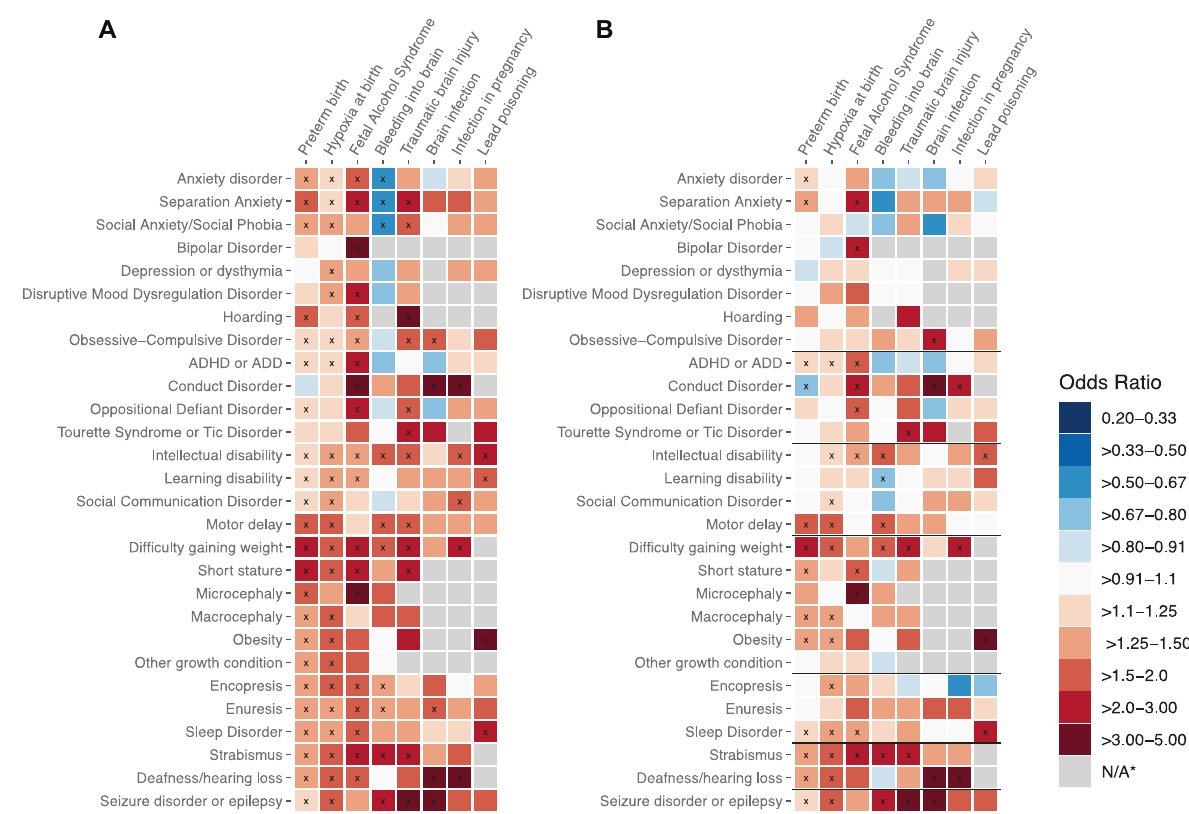
Fig. 4 Associations between pre- and postnatal exposures and comorbidity in individuals with ASD. A The model for each comorbidity was adjusted for maternal and paternal education and age at delivery, child ’ s gender and year of birth, age of the child at evaluation, survey version, race, and annual household income. B In addition to the covariates above, the model for each comorbidity was adjusted for other comorbidities within the same, SPARK-de fi ned disorder domain (domains are demarcated with solid black lines). Blue tiles indicate lower and red tiles higher probability of the diagnosis of the given comorbid condition (y-axis) in individuals with certain environmental exposure ( x -axis). Grey tiles indicate the associations that could not be estimated due to insuf fi cient number of exposed individuals with the comorbidity to allow reliable coef fi cient estimate. x p value < 0.05.